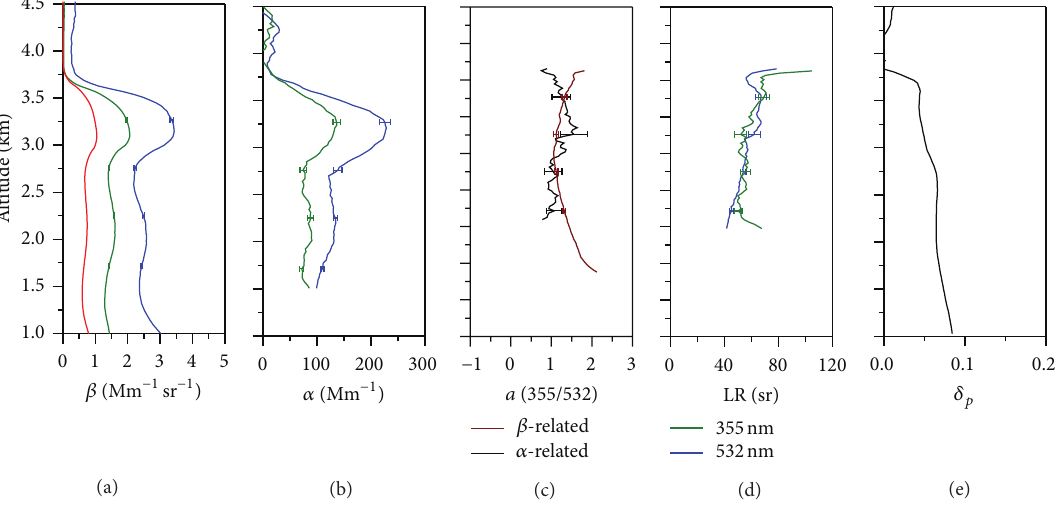
Figure 6: Profiles of (a) backscatter coefficients (355-blue, 532-green, and 1064 nm-red), (b) extinction coefficients (355-blue and 532 nm- green), (c) backscatter and extinction-related ˚Angstr¨om exponent (wavelength pair 355/532 nm), (d) lidar ratios (355 and 532 nm), and (e) particle linear depolarization ratio (532 nm) measured on 19 October 2010 00:00–02:00 UTC.